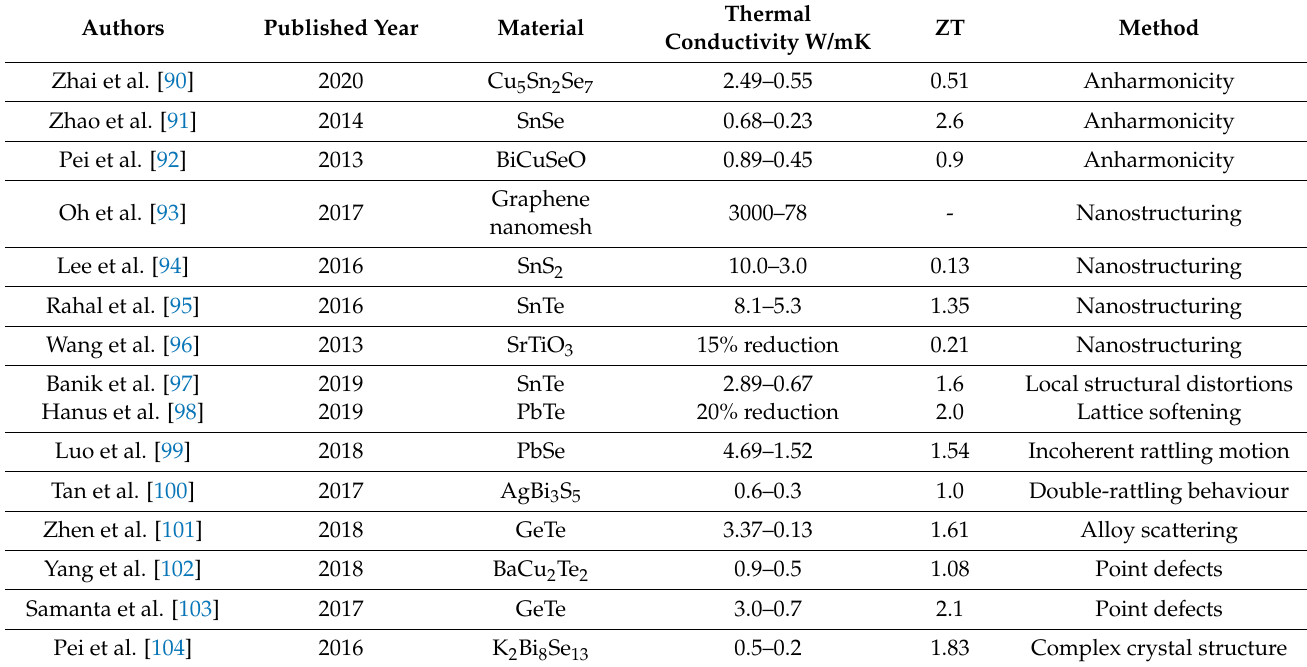
Table 4. Different advanced approaches on minimising κ